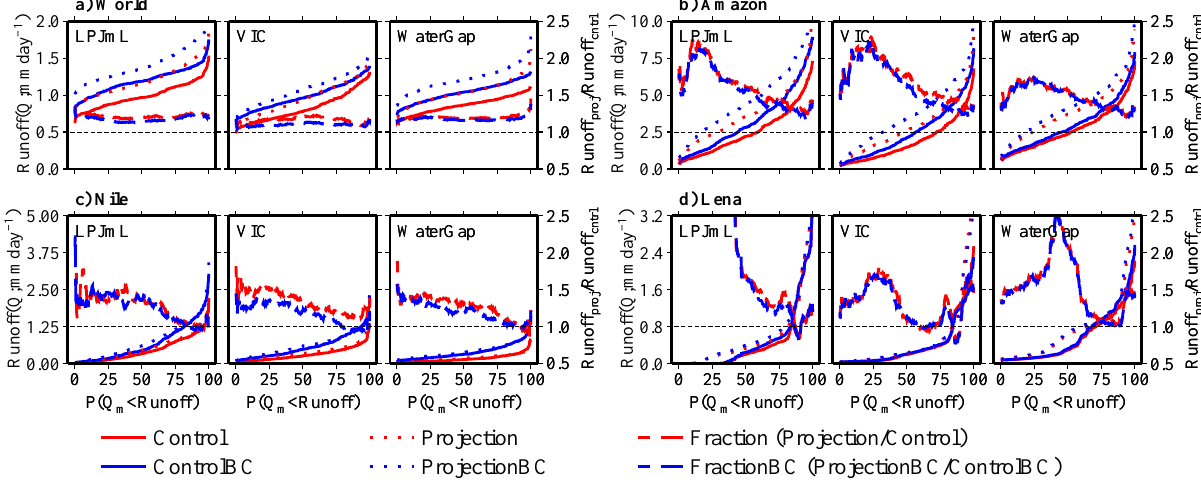
Figure 10: World and basin cumulative distribution functions of monthly simulated runoff ( Q m ) when using IPSL input data, 1971–2000 (control period) and 2071–2100 (projection period), with and without bias correction (BC). Included is also a comparison of the projection period results to the control period results (right y-axis).